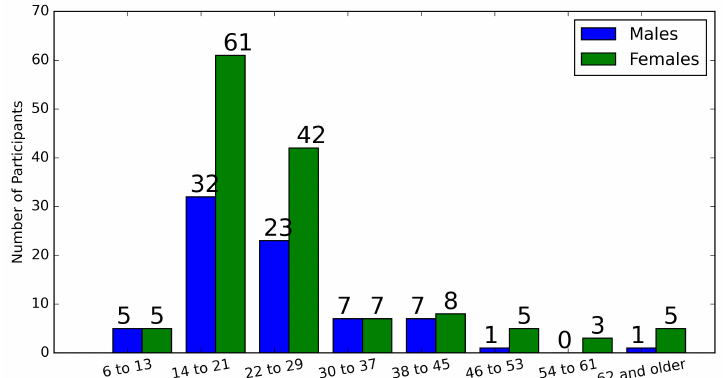
Figure 5. Distributions of age and gender groups of the dataset.